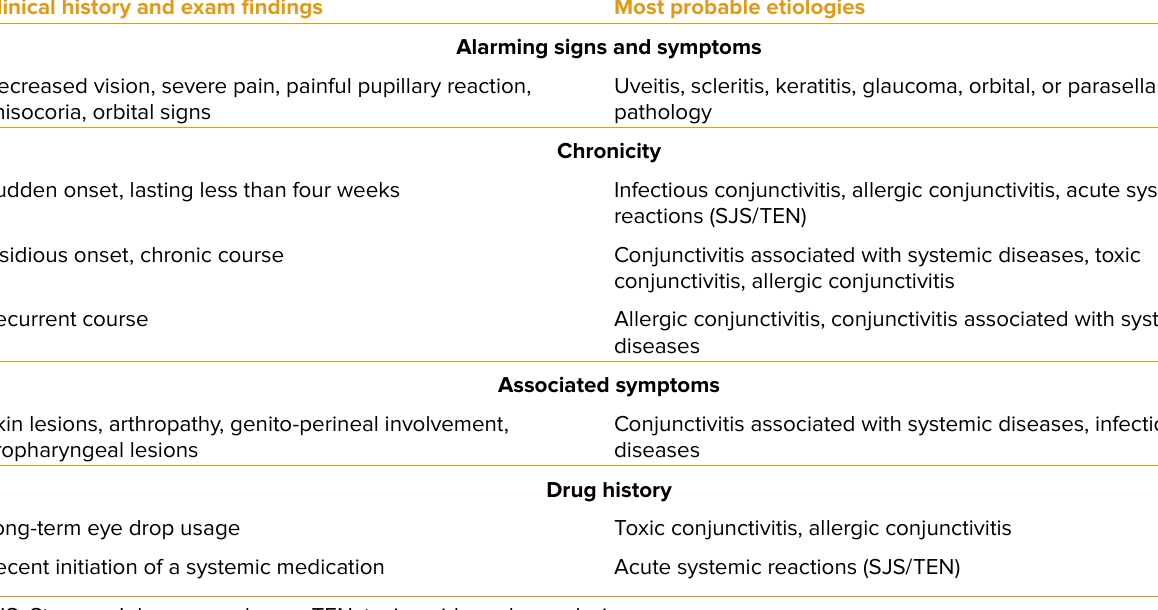
Table 1. Guideline to help differentiate the major etiologies in conjunctivitis Clinical history and exam